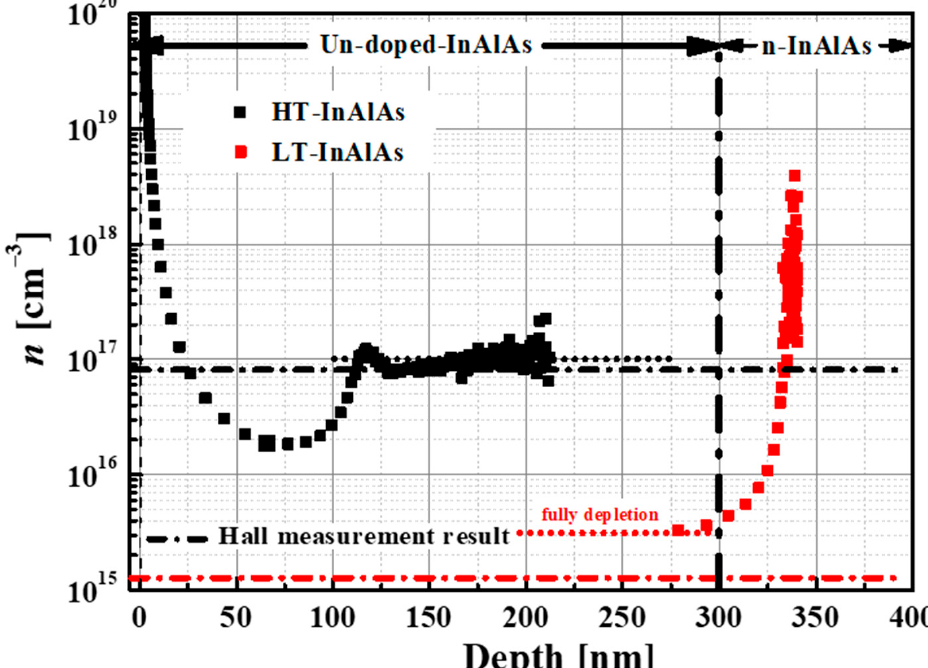
Figure 5. Depth profiles of donor density n extracted from C–V measurement of HT- and LT-InAlAs Schottky diodes with a metal contact area of 4.0 × 10 − 4 cm − 2 . The donor concentration values from the Hall measurement are indicated as dashed dot lines.